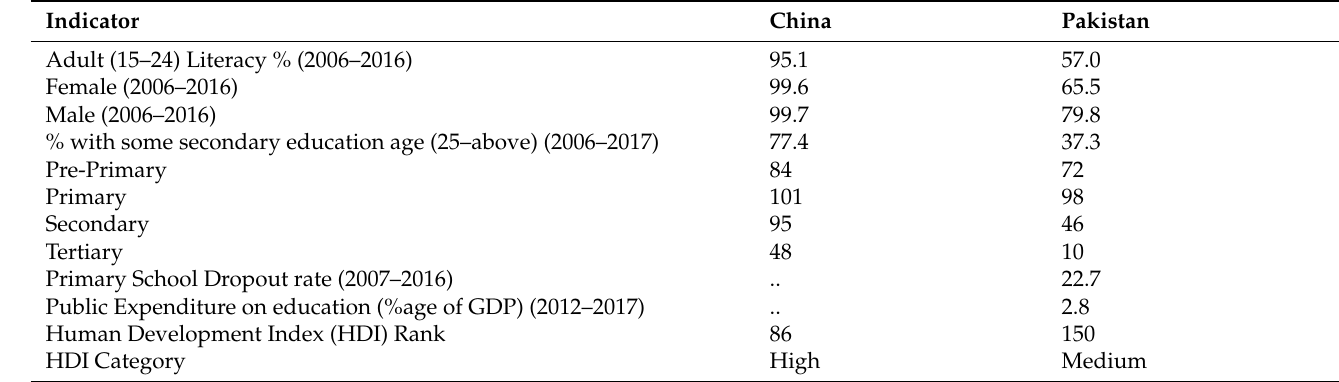
Table 1. Education Indicators; Comparison of China and Pakistan Human Development Report